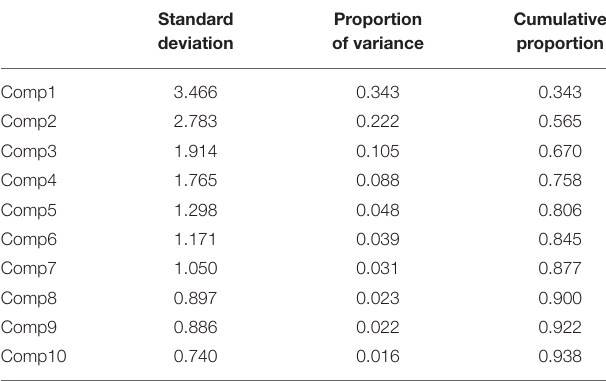
TABLE 3 | Principal component analysis of a logistic regression model based on the correlation matrix for the trust predictor.